Question: What does this figure show? Answer in one sentence.
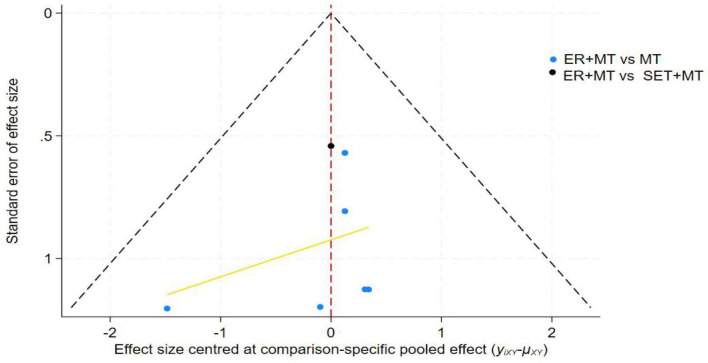
Answer: Comparison-adjusted funnel plot for cardiovascular event incidence. Asymmetrical clustering and a tilted regression line suggest possible publication bias or small-study effects.